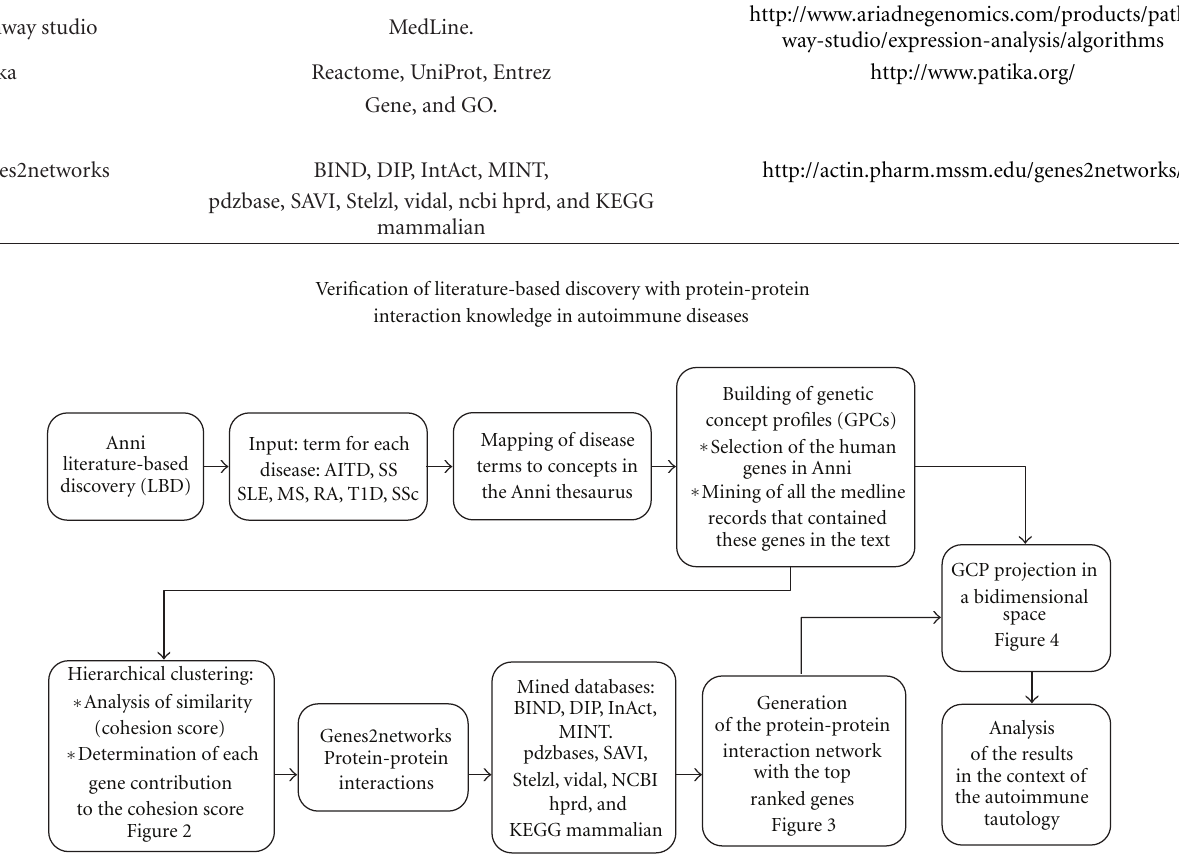
Figure 1: Flowchart of the methodology. AITD: autoimmune thyroid disease, SS: primary Sj¨ogren’s syndrome, SLE: namely systemic lupus erythematosus, MS: multiple sclerosis, RA: rheumatoid arthritis, T1D: type 1 diabetes, and SSc: systemic